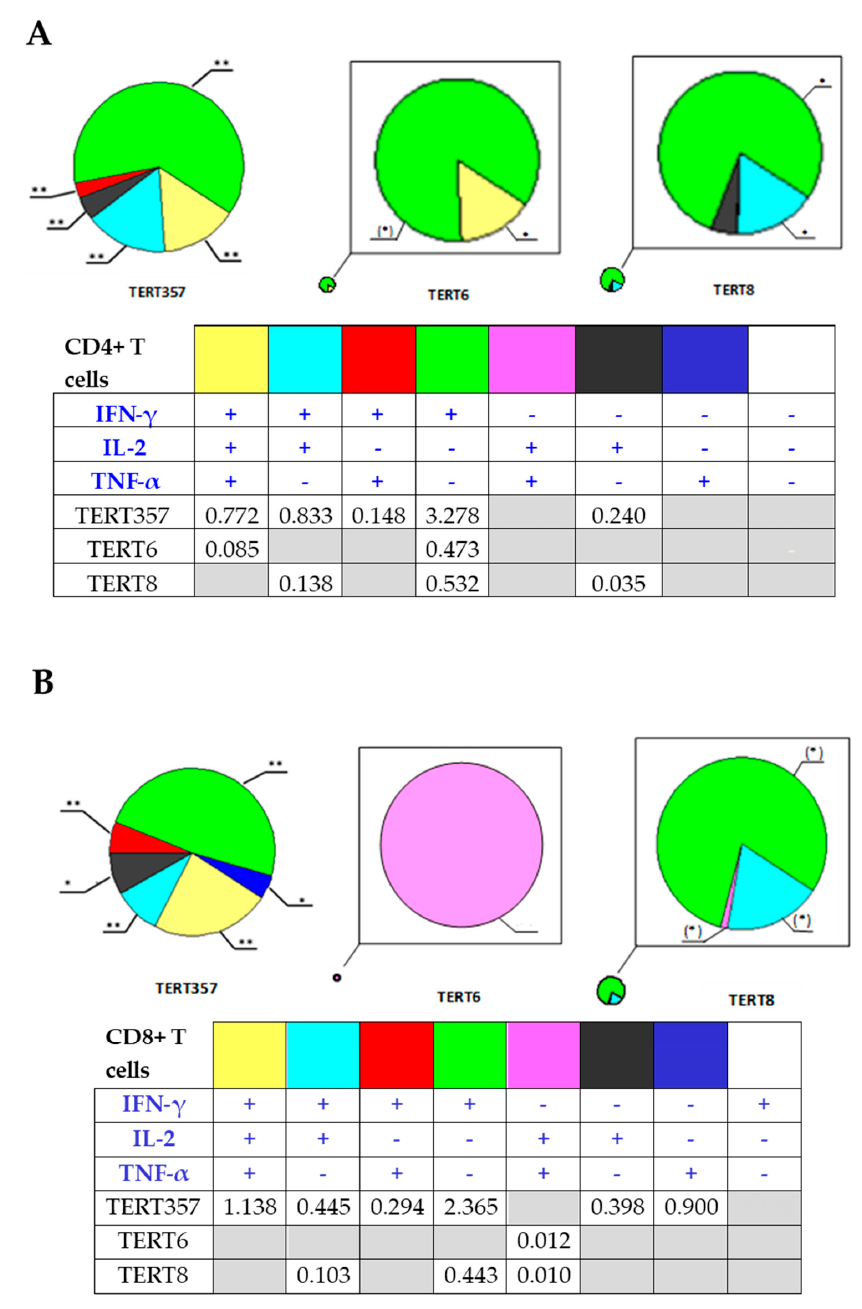
Figure 4. Structure of CD4+ and CD8+ T cell immune response against TERT induced by immunization with pVaxTERT plasmid. Average percent of CD4+ ( A ) and CD8+ ( B ) cells responding to stimulation with peptide pool TERT357, TERT6 and TERT8 (Supplementary Table S1) by production of one, two or three cytokines, visualizing exclusive populations. Tables beneath the graphs show actual percent of the respective populations, of total CD4+ ( A ) or CD8+ T cells ( B ). Populations in which TERT DNA immunized mice tend to differ from vector immunized mice are depicted in grey. Immunization details are described in Materials and Methods and groups, in Table 1. *— p < 0.05, **— p < 0.05 and (*)— p < 0.1 in comparison with vector immunized mice; grey filled empty boxes refer to absence of the respective T cell population ( p > 0.1 compared to vector immunized mice). Statistical analysis in pairwise comparisons by Mann-Whitney U test (Statistica Tibco, version